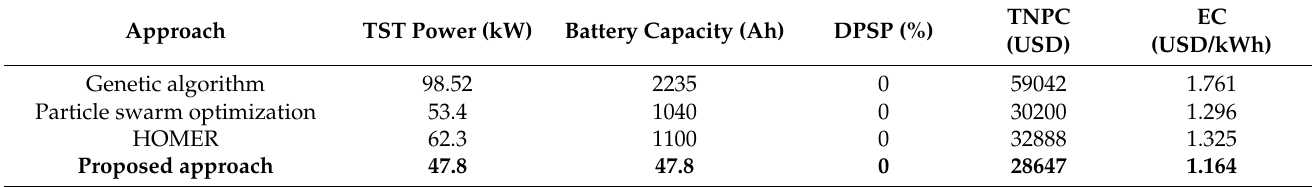
Figure 9. Comparison of DPSP, TNPC, and CE among compared approaches. Table 3. Comparative evaluation of the proposed optimal sizing approach.